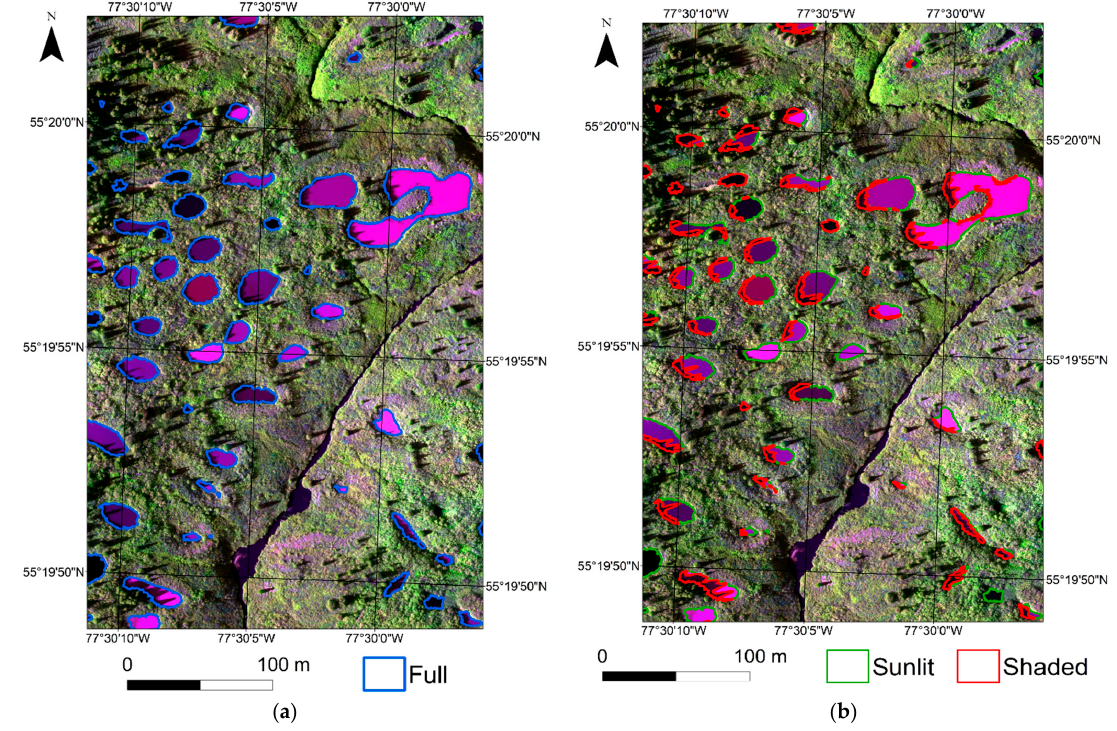
Figure 6. Results of the thermokarst lake and pond classification in a part of the KWAK study area: (a) Results of the delineation using the multiresolution algorithm and NDWI threshold classification; (b) Identification of the shaded and sunlit areas following the K-Means Clustering. Background orthomosaic is a Green (red channel), Red (green channel) and Red Edge (blue channel) color composite obtained from the UAS survey.